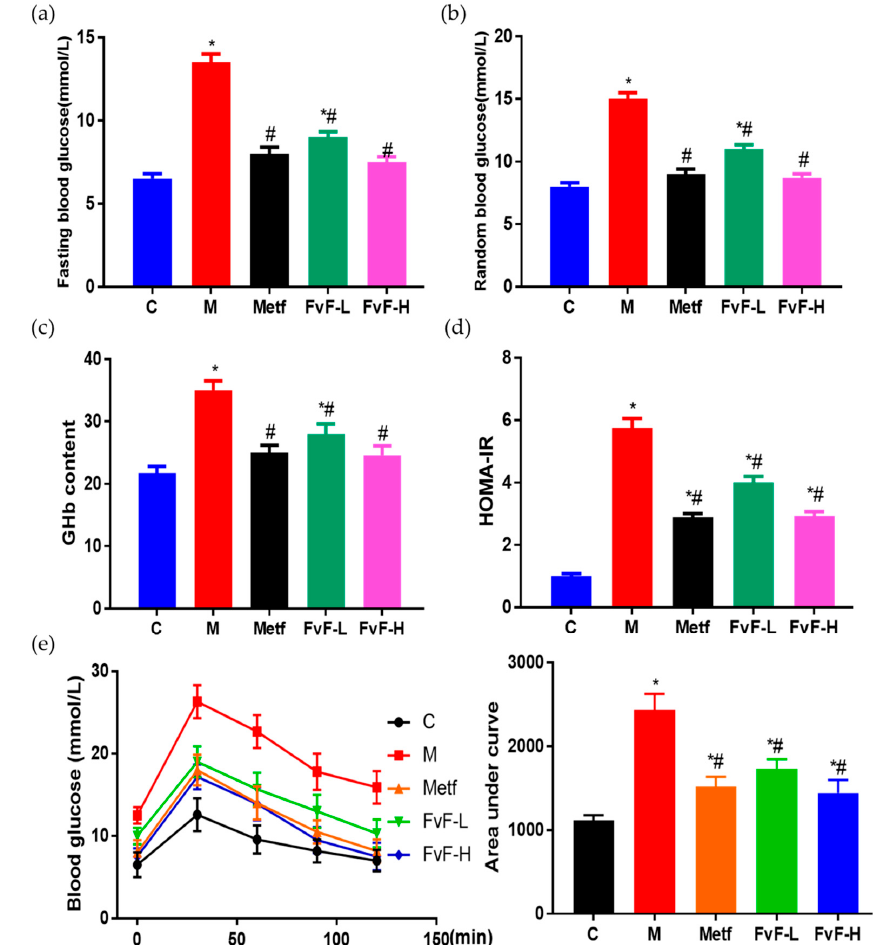
Figure 6. Effects of fucoidan from Fucus vesiculosus (FvF) on the blood glucose related physiological indexes in high-fat diet (HFD) and streptozotocin (STZ)-induced MetS mice. ( a ) Fasting blood glucose;